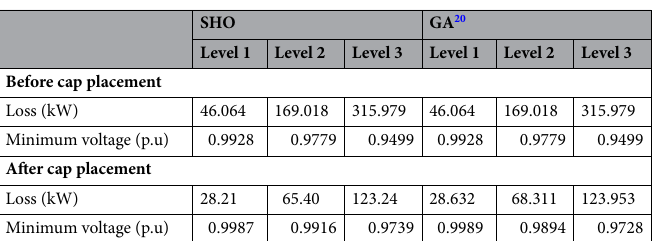
Table 7. Losses and minimum load voltage before and after the capacitor placement in the scenario of connected to the network with cosφ = 1.